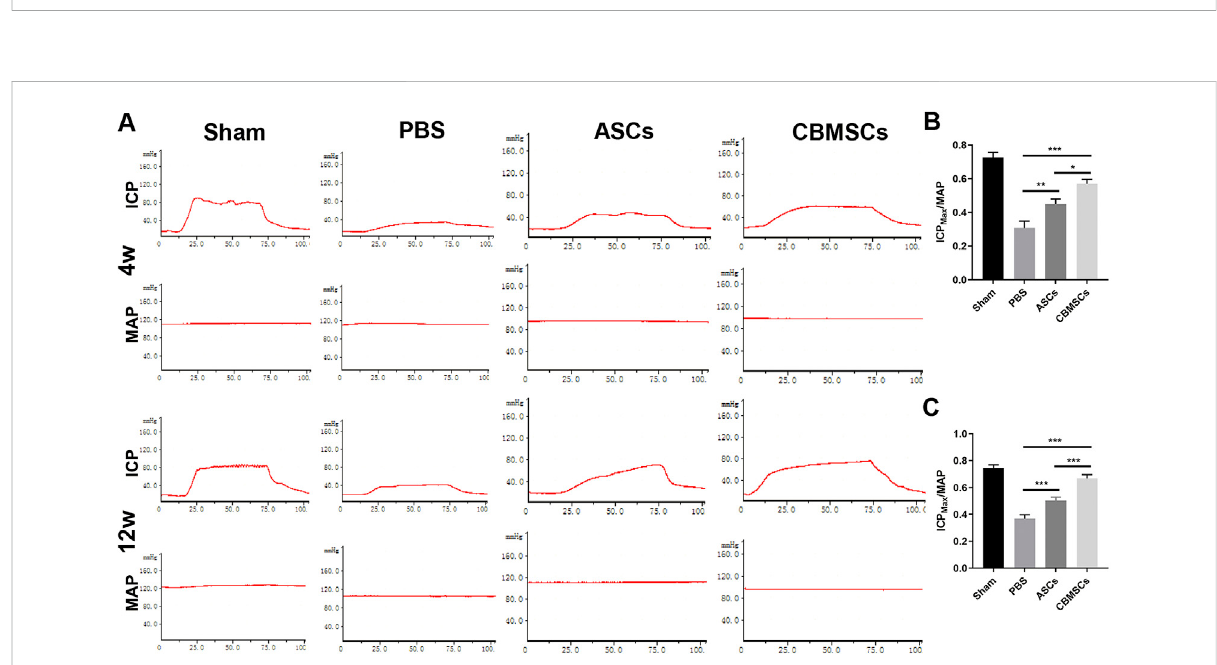
FIGURE 2 ICP/MAP of rats in different groups. (A) Injection of MSCs signi fi cantly restored the erectile function of CNI-ED rats at 4 weeks and 12 weeks after IC injection; the representative images of ICP and MAP after CN electrical stimulation are shown. The statistical analysis of maximal ICP to MAP (ICPmax/MAP) in 4 weeks (B) and 12 weeks (C) are